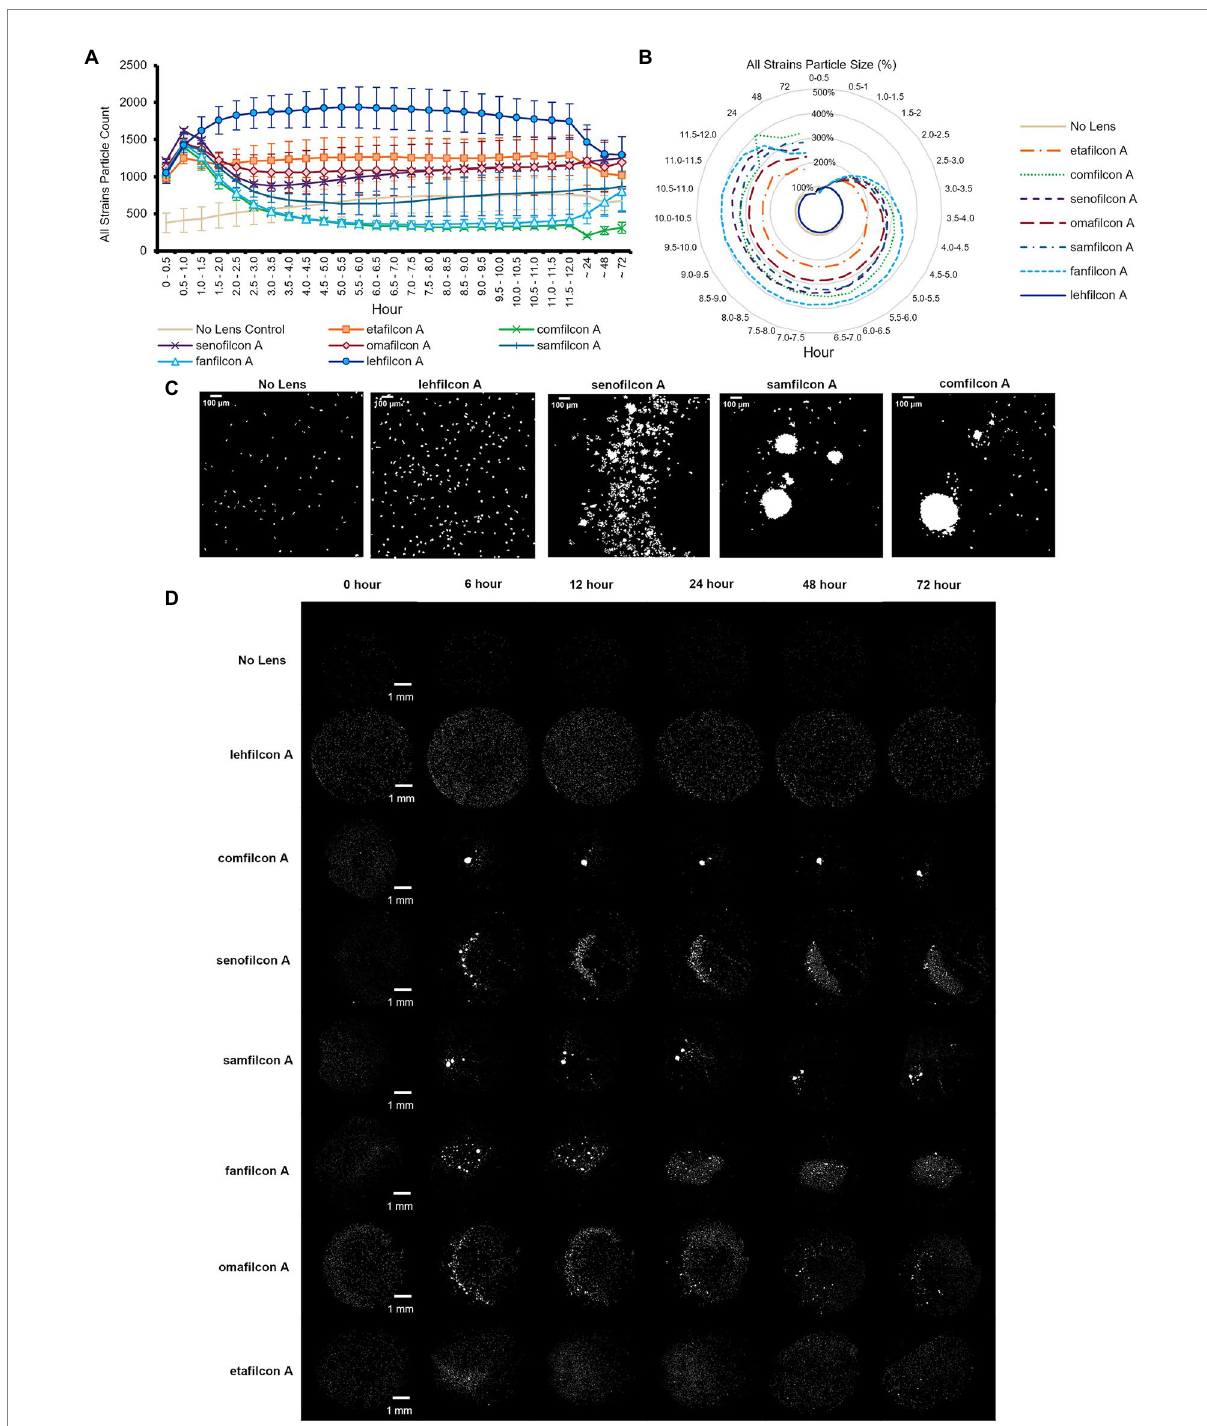
Supplementary Videos S1: ATCC 30010, S2: ATCC 30461,